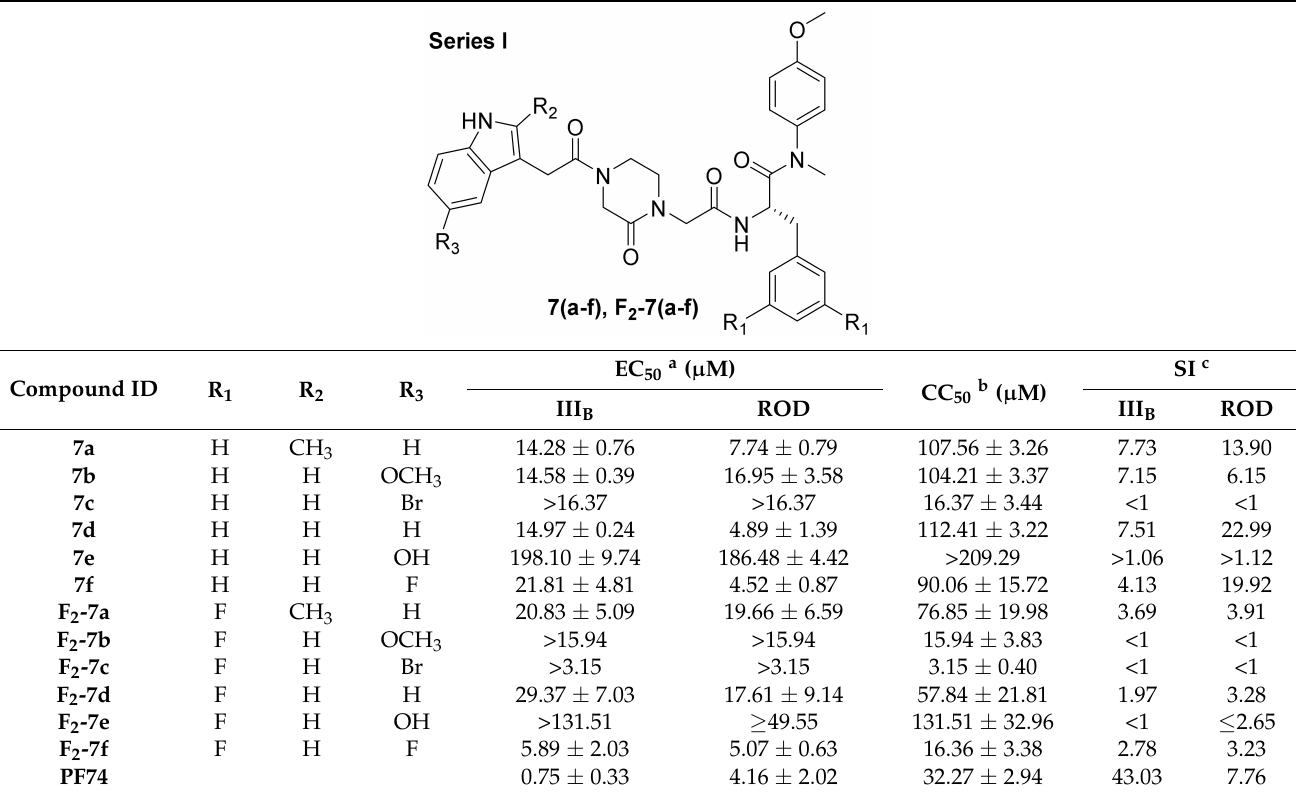
Table 1. Anti-HIV activity and cytotoxicity of series I in MT-4